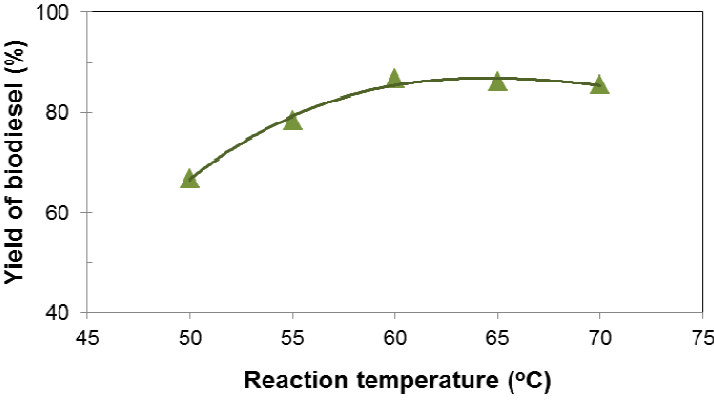
Figure 5. Effect of reaction temperature on the yield of biodiesel in PBR.